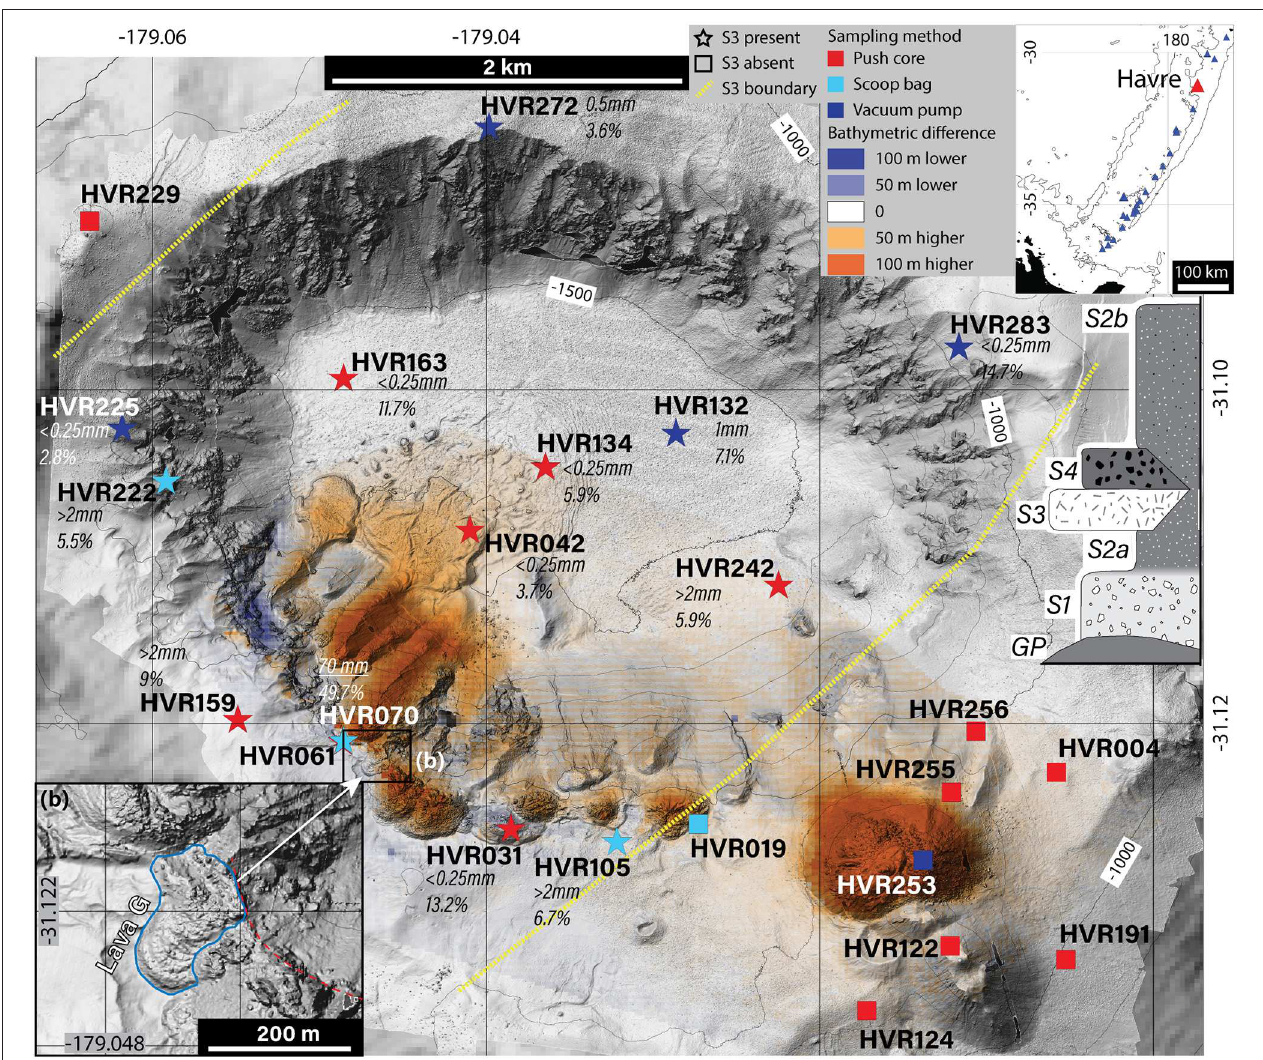
FIGURE 1 | Bathymetry of Havre caldera. Clastic samples categorized by sampling method and presence (star) or absence (square) of significant amounts of particles unique to S3, a subunit of the Ash with Lapilli unit formed during the 2012 eruption. The modal grains size and the weight percentage that elongate tube-vesicle grains make up are shown for each sample that contains grains from S3. From the distribution of samples containing S3 we infer the depositional limits of S3 (yellow dashed lines). Lava G, inferred S3 source, is highlighted in the inset. Lava G has a lobe like shape with concentric surface ridges and is truncated on its north eastern edge by a scarp (red dashed line). Inset top right shows regional context of the Kermadec Arc north of New Zealand, with Havre volcano in red, other Kermadec volcanoes in blue.